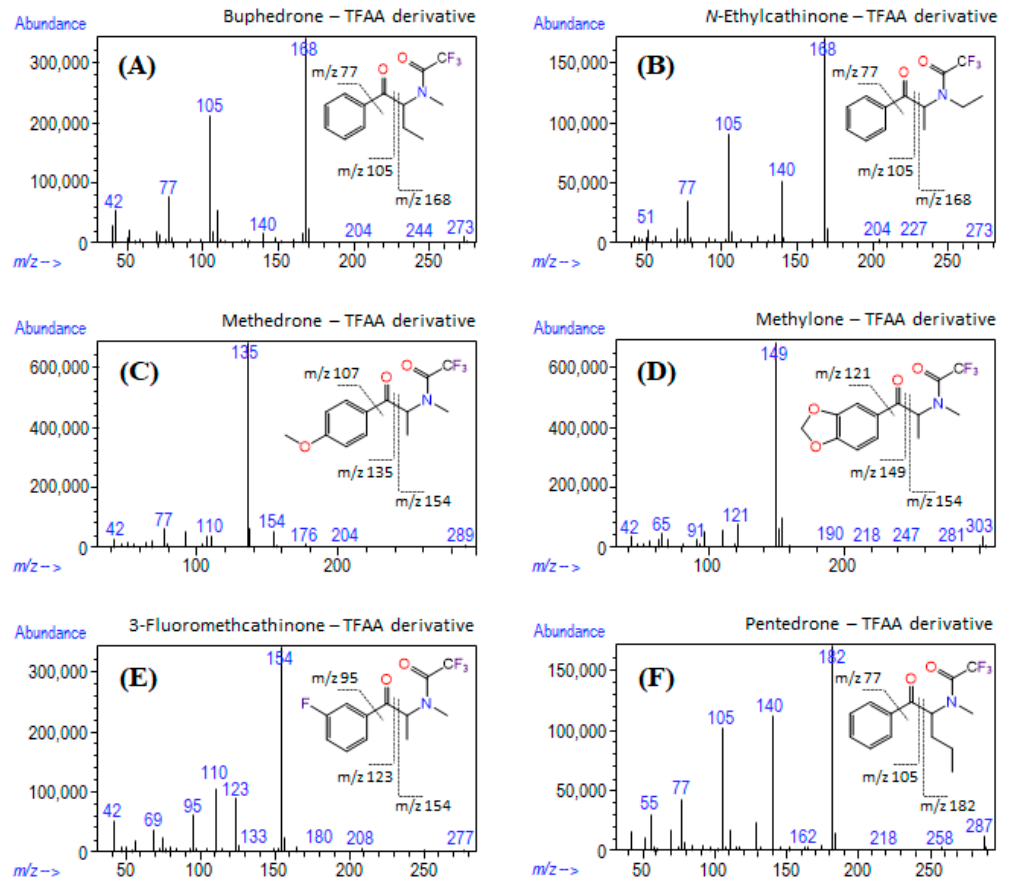
Figure 5. EI mass spectra of ( A ) buphedrone ( B ) N -ethylcathinone ( C ) methedrone ( D ) methylone ( E ) 3-FMC and ( F ) pentedrone after derivatization with